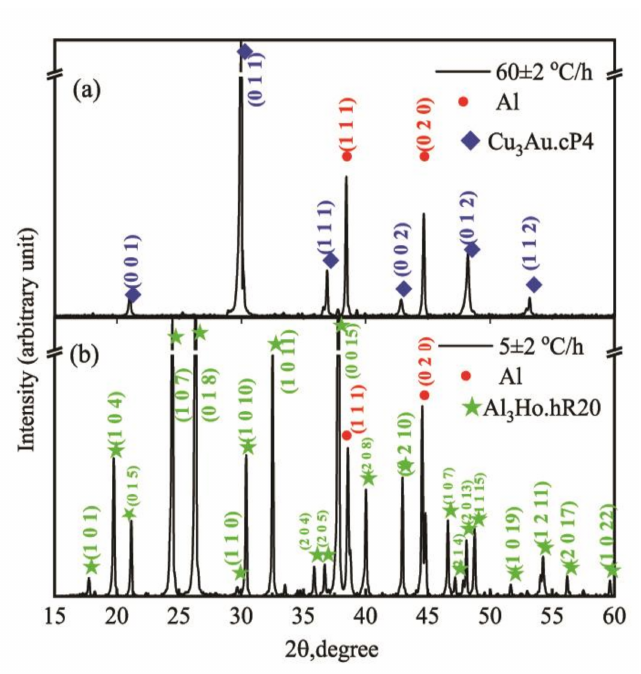
Figure 2. XRD spectrum of Al-30 wt.% Er for cooling rate of ( a ) 60 ± 2 ◦ C/h and ( b ) 5 ± 2 ◦ C/h, respectively. The results indicated that the Cu 3 Au.cP4 structure Al 3 Er formed in the alloy with a higher cooling rate of 60 ± 2 ◦ C/h, while the Al 3 Ho.hR20-structured Al 3 Er